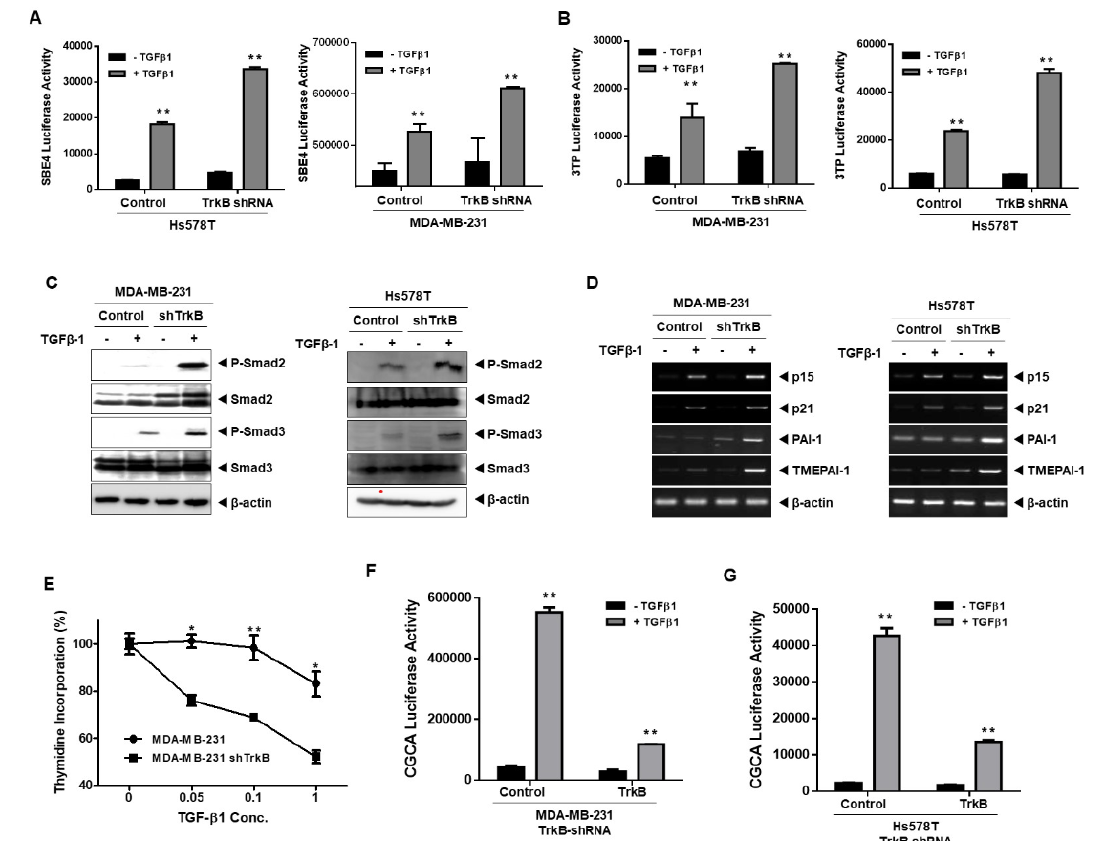
Figure 5. Loss of TrkB restored TGF- β signaling. Luciferase reporter assay of TGF- β 1-responsive SBE ( A ) or 3TP ( B ) in Hs578T and MDA-MB-231 control-shRNA or TrkB-shRNA cells. ** Control versus treatment with TGF- β 1, p < 0.05. n = 3. ( C ) Western blot analysis of the expression of phospho-SMAD2, phospho-SMAD3, SMAD2, and SMAD3 in Hs578T and MDA-MB-231-control-shRNA or TrkB-shRNA cells after stimulation with TGF- β 1 (5 ng / mL). ( D ) RT-PCR analyses of p15 Ink4b , p21 Cip1 , PAI1, and TMEPAI mRNAs in Hs578T and MDA-MB-231-control-shRNA or TrkB-shRNA cells after treatment with or without TGF- β 1 (5 ng / mL). ( E ) Thymidine incorporation assay of MDA-MB-231 control-shRNA or TrkB-shRNA cells treated with various concentrations of TGF- β 1 as indicated. Points, averages of means from three determinations; bars, SD. * Control versus treatment with TGF- β 1, p < 0.03. n = 3. ** Control versus treatment with TGF- β 1, p < 0.05. n = 3. ( F , G ) Luciferase reporter assay of SMAD3-dependent (CAGA) 12 -Luc in TrkB transiently transfected MDA-MB-231 ( F ) or Hs578T TrkB-shRNA ( G ) cells. ** Control versus treatment with TGF- β 1, p < 0.05. n = 3.